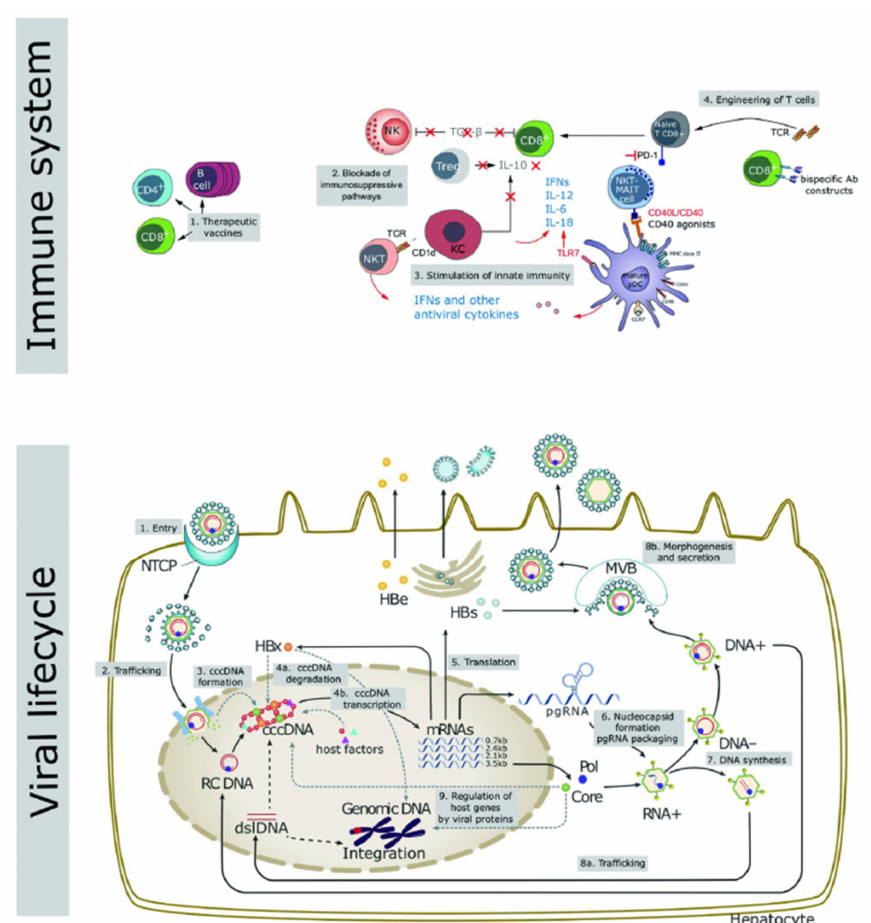
Figure 1. Key aspects of the viral life cycle and host immune system representing the novel targets for the development of innovative therapeutic strategies to counteract HBV infection. Reproduced from Liver International 2017, 37 (Suppl. 1),